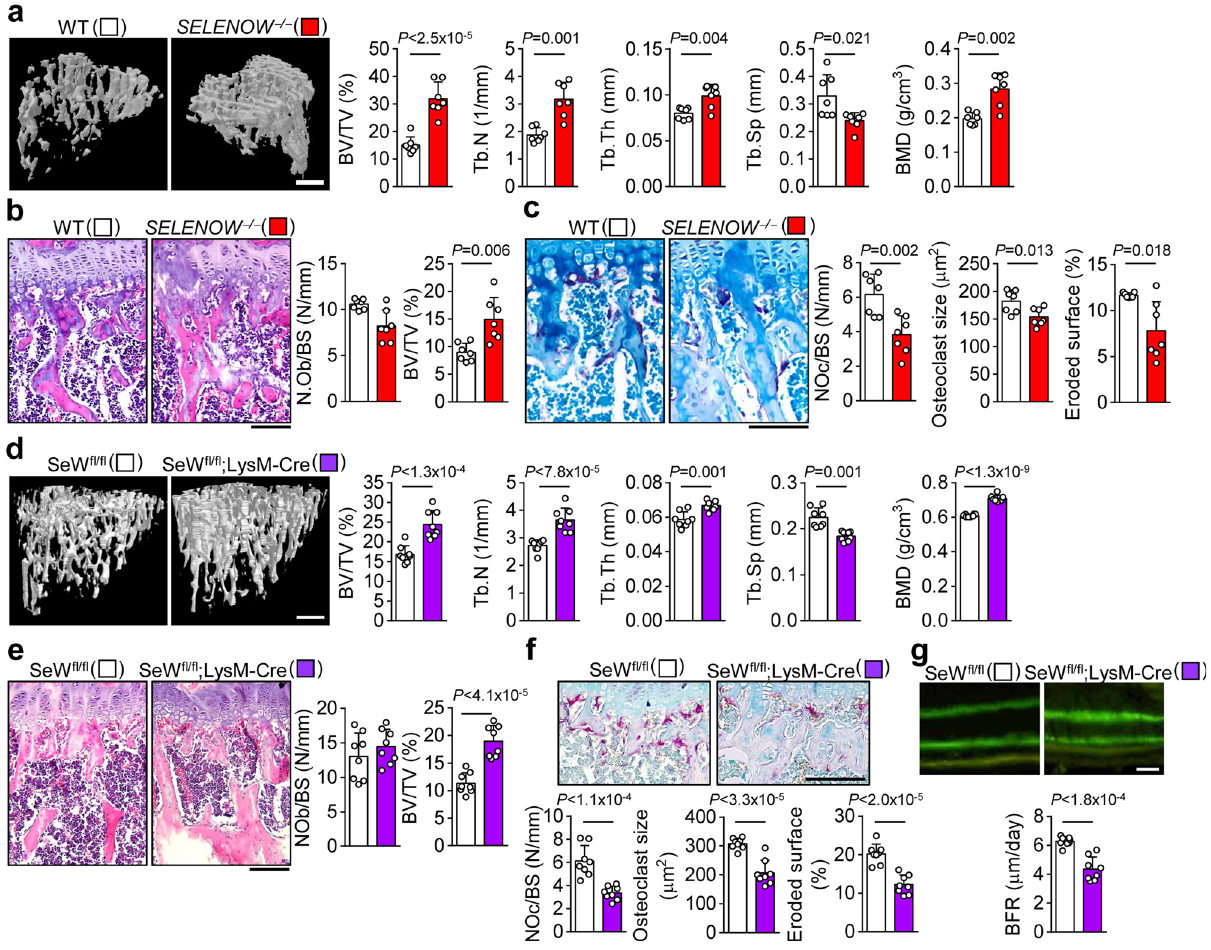
Fig. 2 Increased bone mass phenotypes in mice with SELENOW de fi ciency. a μ CT analysis of proximal tibiae from wild-type (WT) male littermates and age/ sex-matched SELENOW − / − mice at 10 weeks. BV/TV, trabecular bone volume per tissue volume; Tb.N, trabecular bone number; Tb.Th, trabecular thickness; Tb. Sp, trabecular separation; BMD, bone mineral density. Scale bar, 0.5mm. b , c Reduced osteoclast formation on the trabecular bone surface of SELENOW − / − mice. H&E- and TRAP-stained sections of tibiae were used to detect osteoblasts ( b ) and osteoclasts ( c ), respectively. NOb/BS, number of osteoblasts per bone surface; NOc/BS, BV/TV, trabecular bone volume per tissue volume; number of osteoclasts per bone surface. In addition, osteoclast size and eroded bone surface were analysed from the TRAP-stained sections. Scale bar, 100 μ m. d Increased bone mass phenotype in μ CT analysis of proximal tibiae from WT male littermates ( SELENOW tm1c/tm1c ; SeW fl / fl ) and age/sex-matched osteoclast-speci fi c SELENOW knockout mice ( SELENOW tm/c/tm1c :LysM-Cre; SeW fl / fl